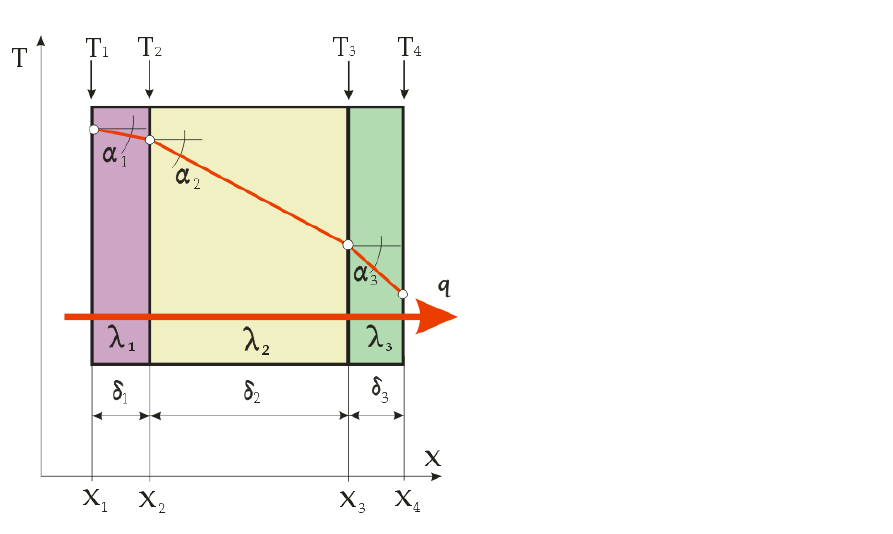
Figure 2. Temperature field in three-layer flat composite clothing ( λ = const.).